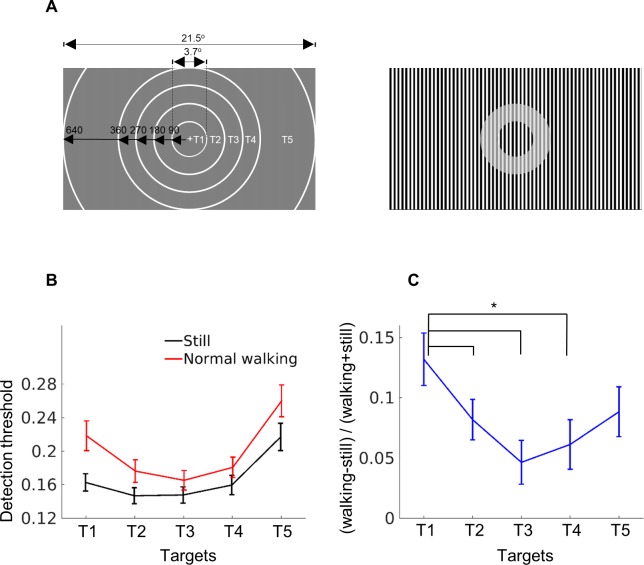
Walking leads to a processing advantage of peripheral stimuli.(A) Schematic illustration of the stimulus. Left, the size and position of all five targets (T1–T5) of contrast change are marked by circular white lines (not visible for the participant), corresponding to the ratio of real stimulus presentation. Stimulus size is given in pixel and visual angle. Right, an example of a T2 contrast change is shown. Note that the grating background was constantly at 100% contrast. (B) Detection threshold for all targets in both standing still and normal walking condition. (C) The relative detection threshold difference between normal walking and standing still for all targets. Each connected pair showed a significant difference (post hoc t test with FDR-adjusted p-values for multiple comparisons, p < 0.05). Vertical lines indicate ±1 standard error, n = 27 participants. The original data are available from https://doi.org/10.6084/m9.figshare.9094742.v1. FDR, false discovery rate.